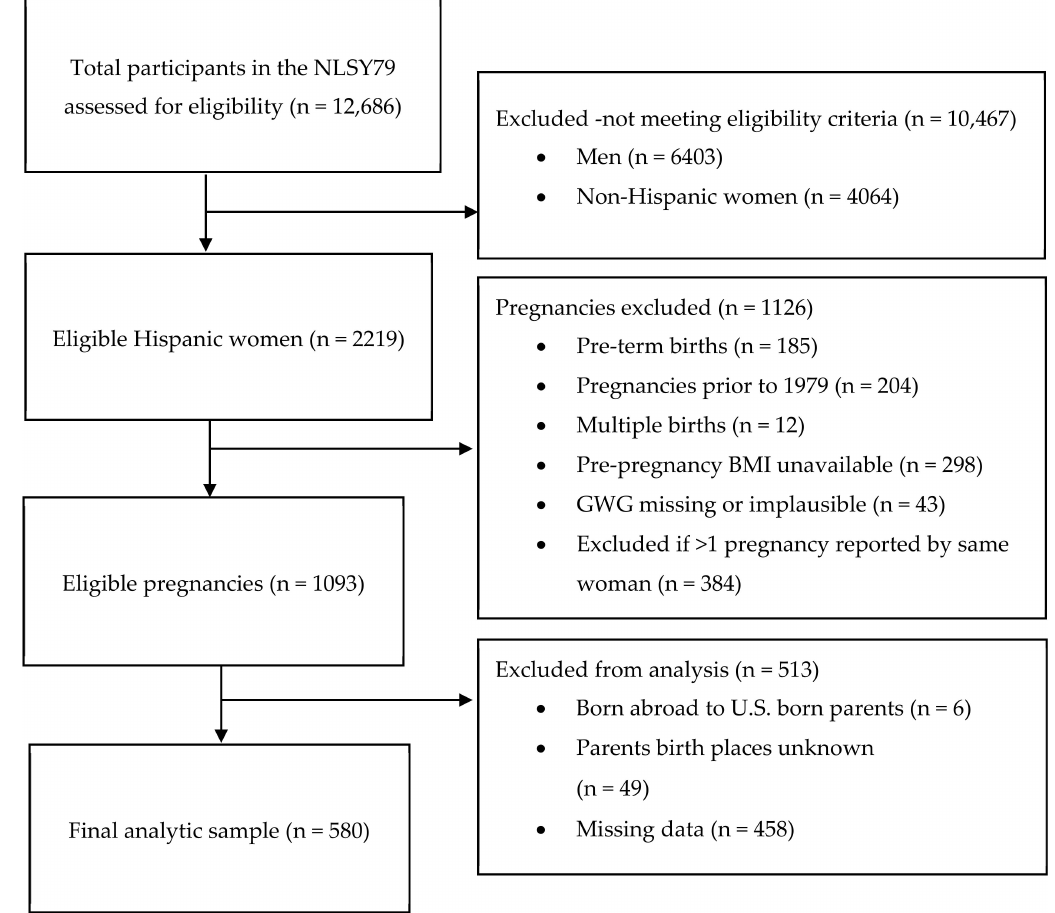
Figure 1. The study sample selection process (the unweighted counts are